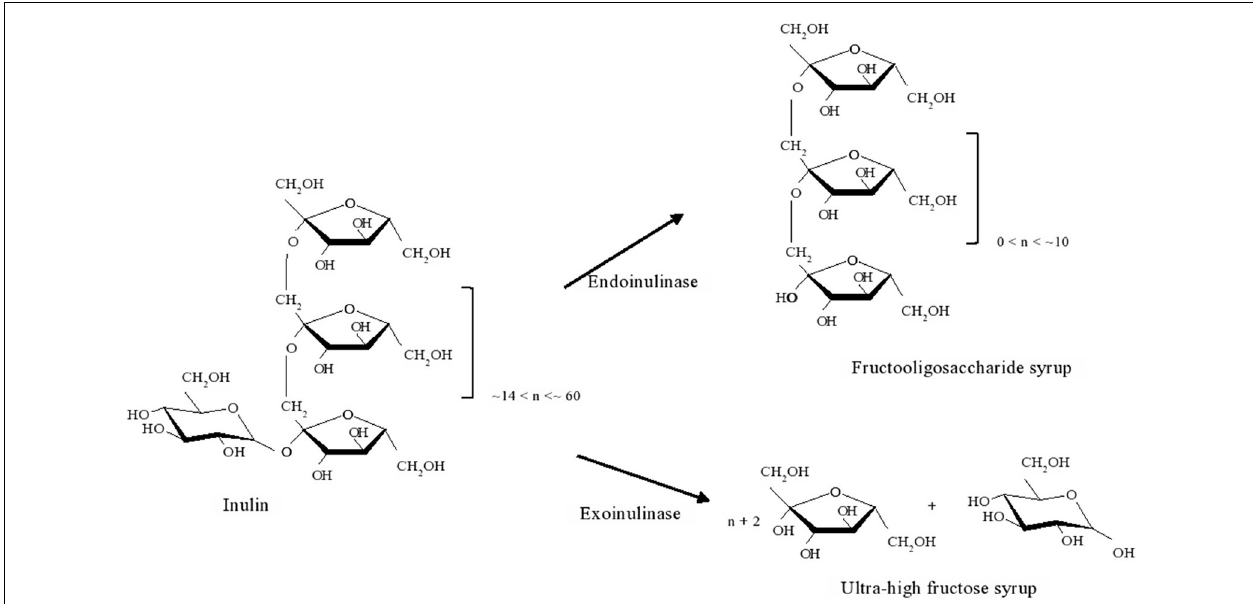
FIGURE 2 | Schematics of the action of endoinulase or exoinulinase on inulin, to produce fructooligosaccharide syrup or ultra-high fructose syrup respectively.